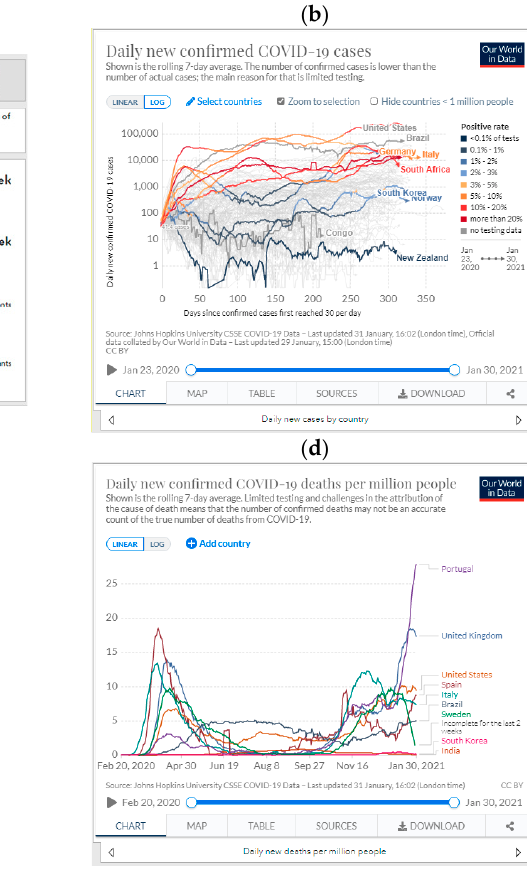
Figure 5. Example of dashboard elements for the international scale. Source: https://www.comprime-compri-mov.com (accessed on 9 February 2021).